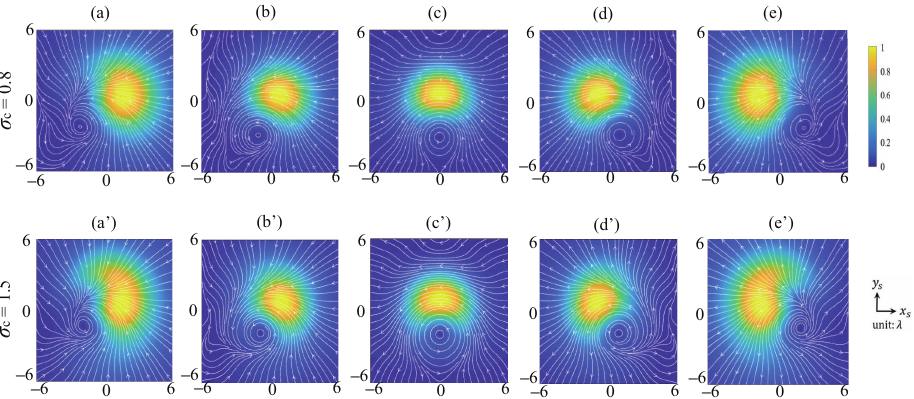
Figure 8. The transverse energy flux s xy along the propagation direction. Here, ( a , a’ ) z s = − 4 λ , ( b , b’ ) z s = − 2 λ , ( c , c’ ) z s = 0, ( d , d’ ) z s = 2 λ and ( e , e’ ) z s = 4 λ . In all plots: a = 0.5 w 0 , f = 2 mm, w 0 = 2 mm and α = 60 ◦